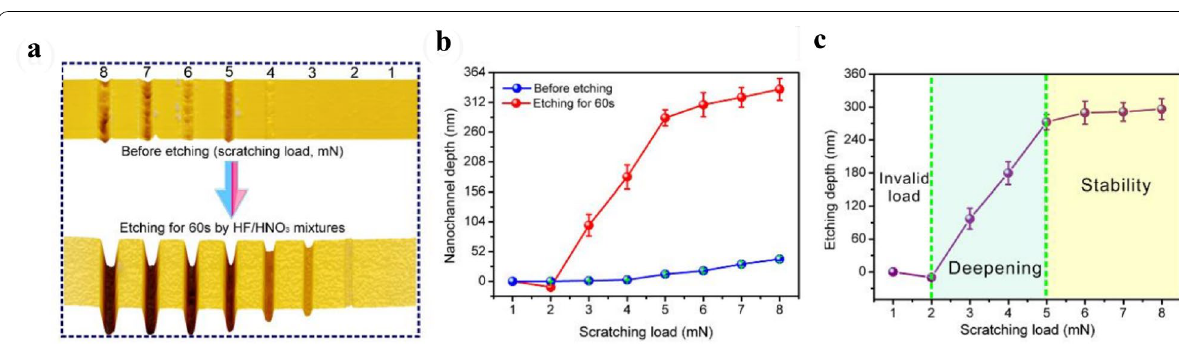
Figure 16 Normal load-dependent friction-induced selective etching in HF/HNO 3 mixture